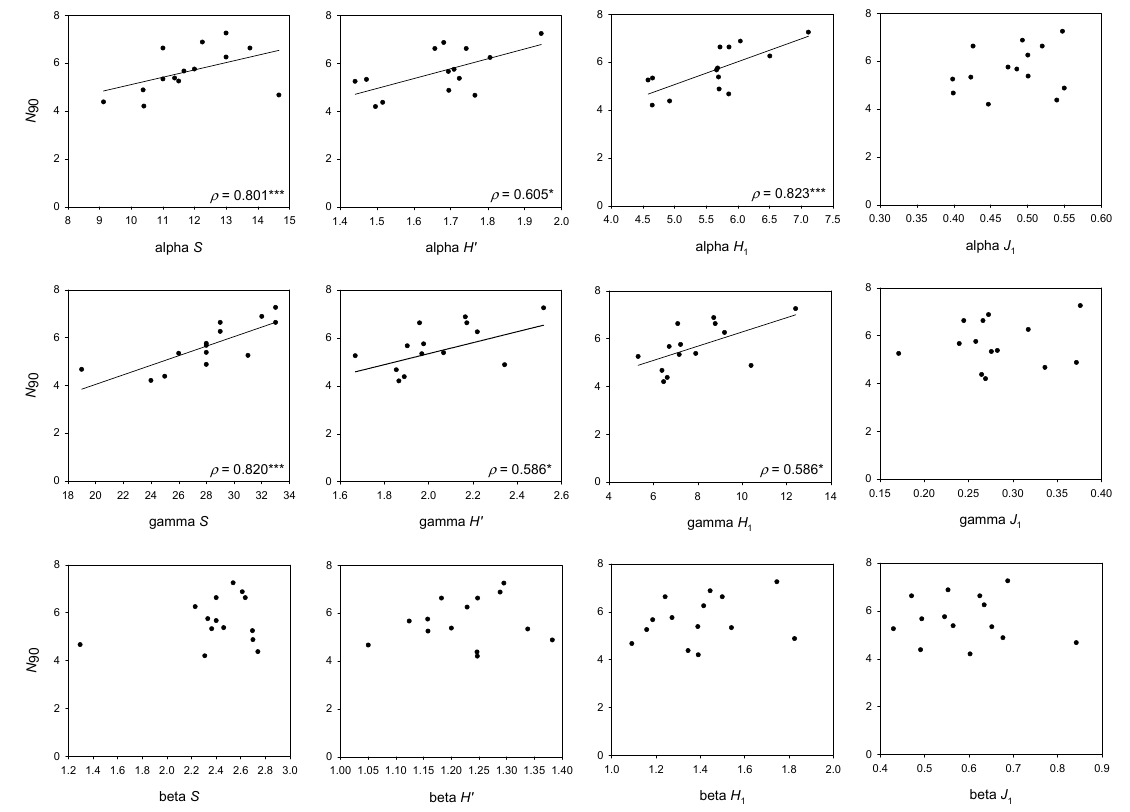
Figure 5. Results of the linear regression analysis of N 90 with alpha, beta and gamma versions of Species Richness ( S ), Shannon ( H’ ), Hill number of order 1 ( H 1 ) and the derived evenness measure ( J 1 ), considering the middle slope stratum (501–800 m depth). The results for alpha, beta and gamma versions of J ’ are not plotted because they do not show any correlation with N 90 . Spearman’s rank correlation coefficient ( ρ ) and p -values are presented. (*) p < 0.05; (**) p < 0.01; (***) p < 0.001.